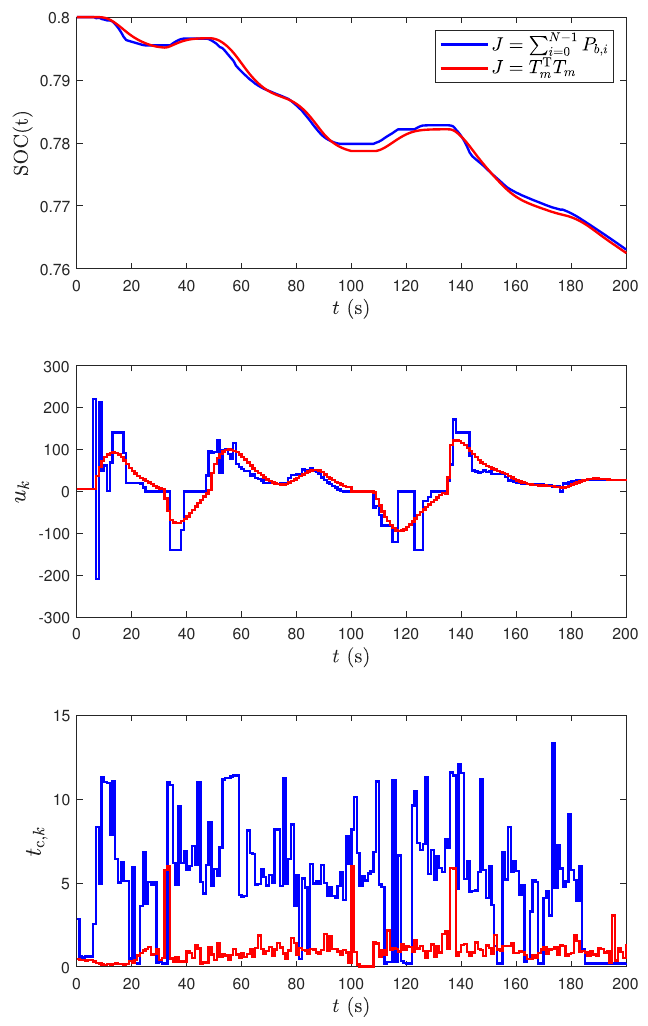
Figure 6. Comparison of the simulation results using the different cost functions with N = 10 and T s = 1 s. The top plot shows the battery SOC trajectories, the middle plot shows the control input evolutions, and the bottom plot shows the computation times t c, k at each step k